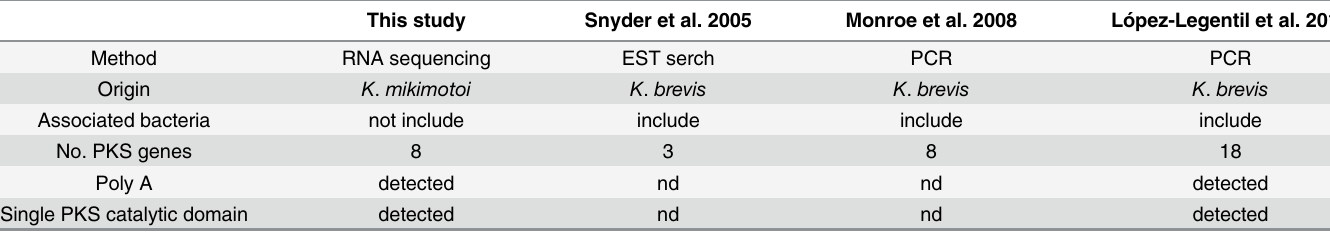
Table 7. Reports of PKS transcripts in genus Karenia